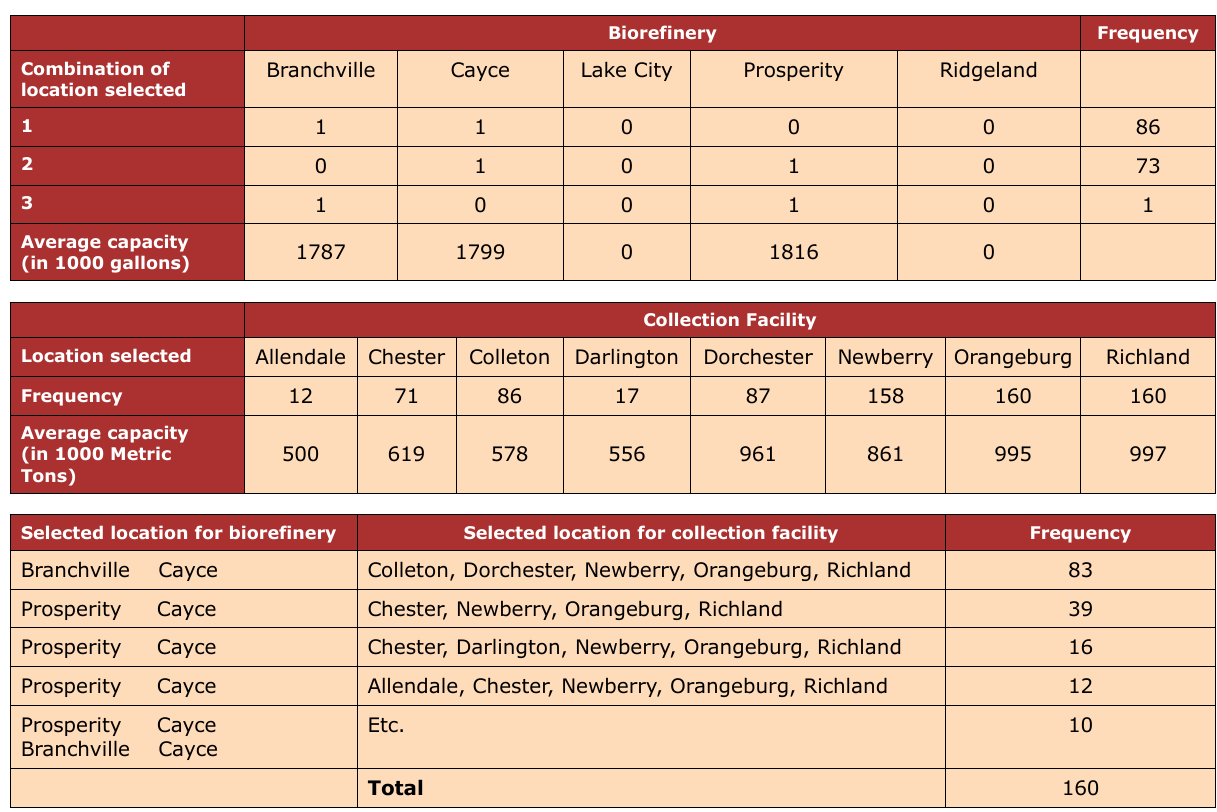
Table 3. Summary of Simulation Results of Locations of Biorefinery and Collection